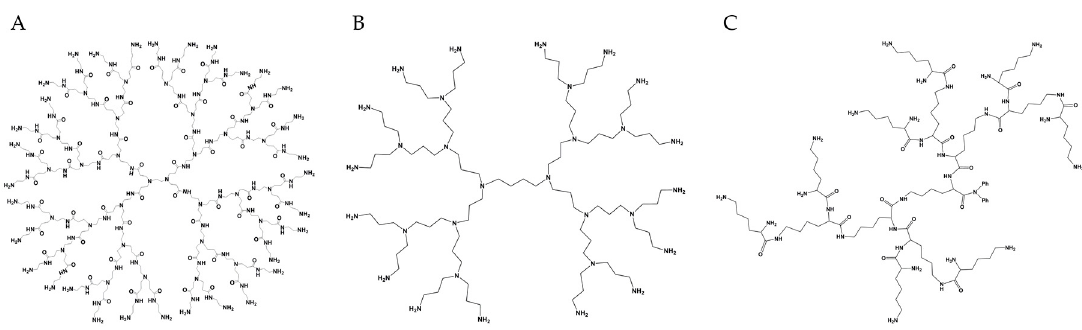
Figure 1. Schematic representation of third generation dendrimers. ( A ) PAMAM with ethylenediamine core; ( B ) PPI with 1,4-diaminobutane core; ( C ) PLL with Boc-l-Lys(Boc)-OH benzhydrylamide core. Illustrations generated by ChemDraw Professional Version 16.0.1.4.